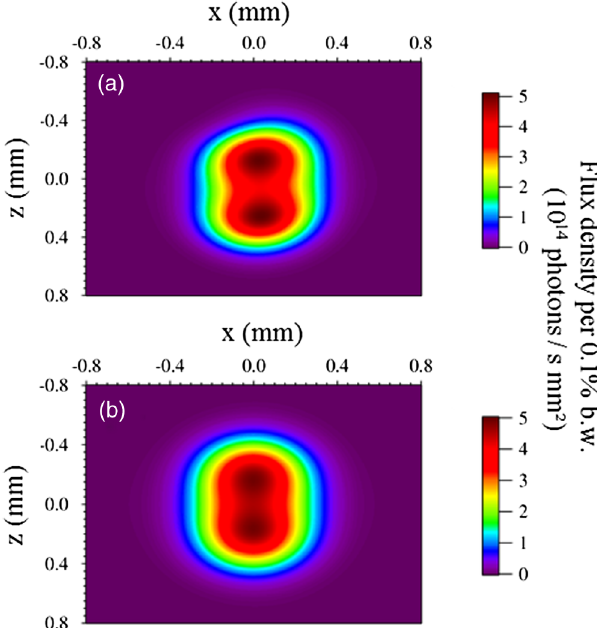
FIG. 7. On-axis photon spectra for the ninth energy harmonic emitted from the U20 undulator in the presence of the 10 T solenoid field taking into account the electron trajectories presented in Fig. 6. Horizontal and vertical entrance angle are equal to 0 μ rad (black), 14 μ rad (red) and 30 μ rad (blue).